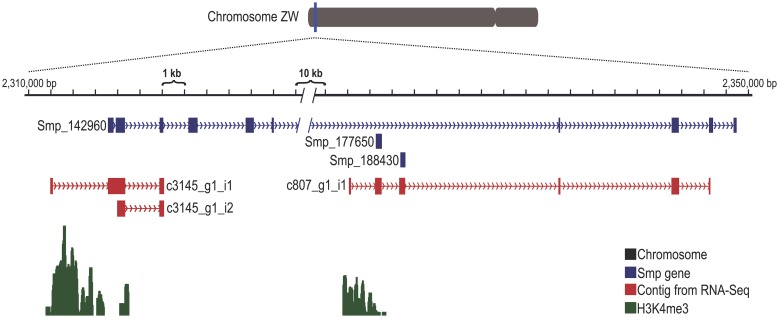
Contigs from the RNA-Seq data improve the Smp gene predictions, including the rearrangement of gene structure and the addition of new 5′-ends.The figure shows a Chromosome ZW 40-kb locus (Chr_ZW:2,310,000–2,350,000) harboring Smp_142960, Smp_177650 and Smp_188430 (blue). Contigs (red) from our RNA-Seq assembly align to Smp genes, showing their new architecture. The new contig c807_g1_i1 (red boxes on the right-hand side) merges Smp_177650 and Smp_188430 with the final exons from Smp_142960 and has a new 5′-end exon that overlaps the histone H3K4me3 peak (green). The new contig c3145_g1_i1 (red boxes on the left-hand side) matches the first two exons of Smp_142960 and adds a new 5′-end exon that corrects the TSS of the gene and overlaps the histone H3K4me3 peak (green). This locus can be seen at http://schistosoma.usp.br/ by entering the chromosome coordinates, the Smp number or the contig number in the “enter position or search terms” field at the top of the browser.